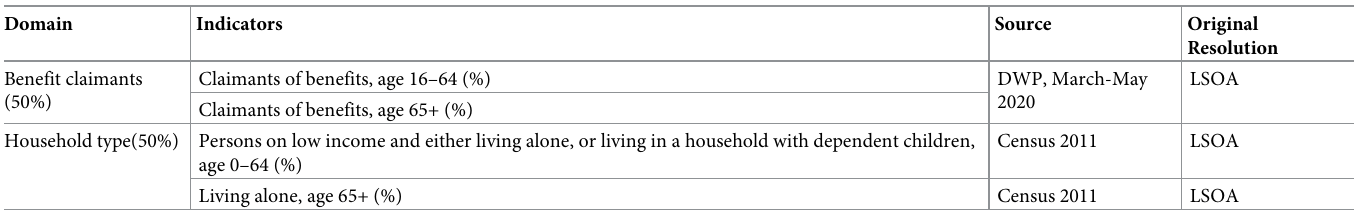
Table 1. Simple index domains and